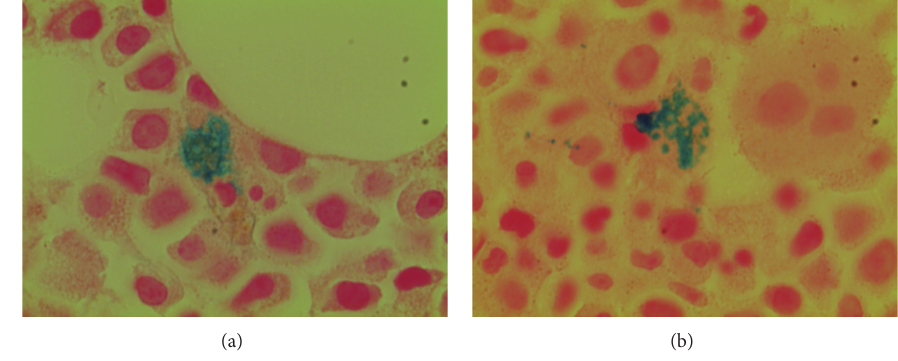
Figure 1: Bone marrow biopsy demonstrating hemophagocytosis.